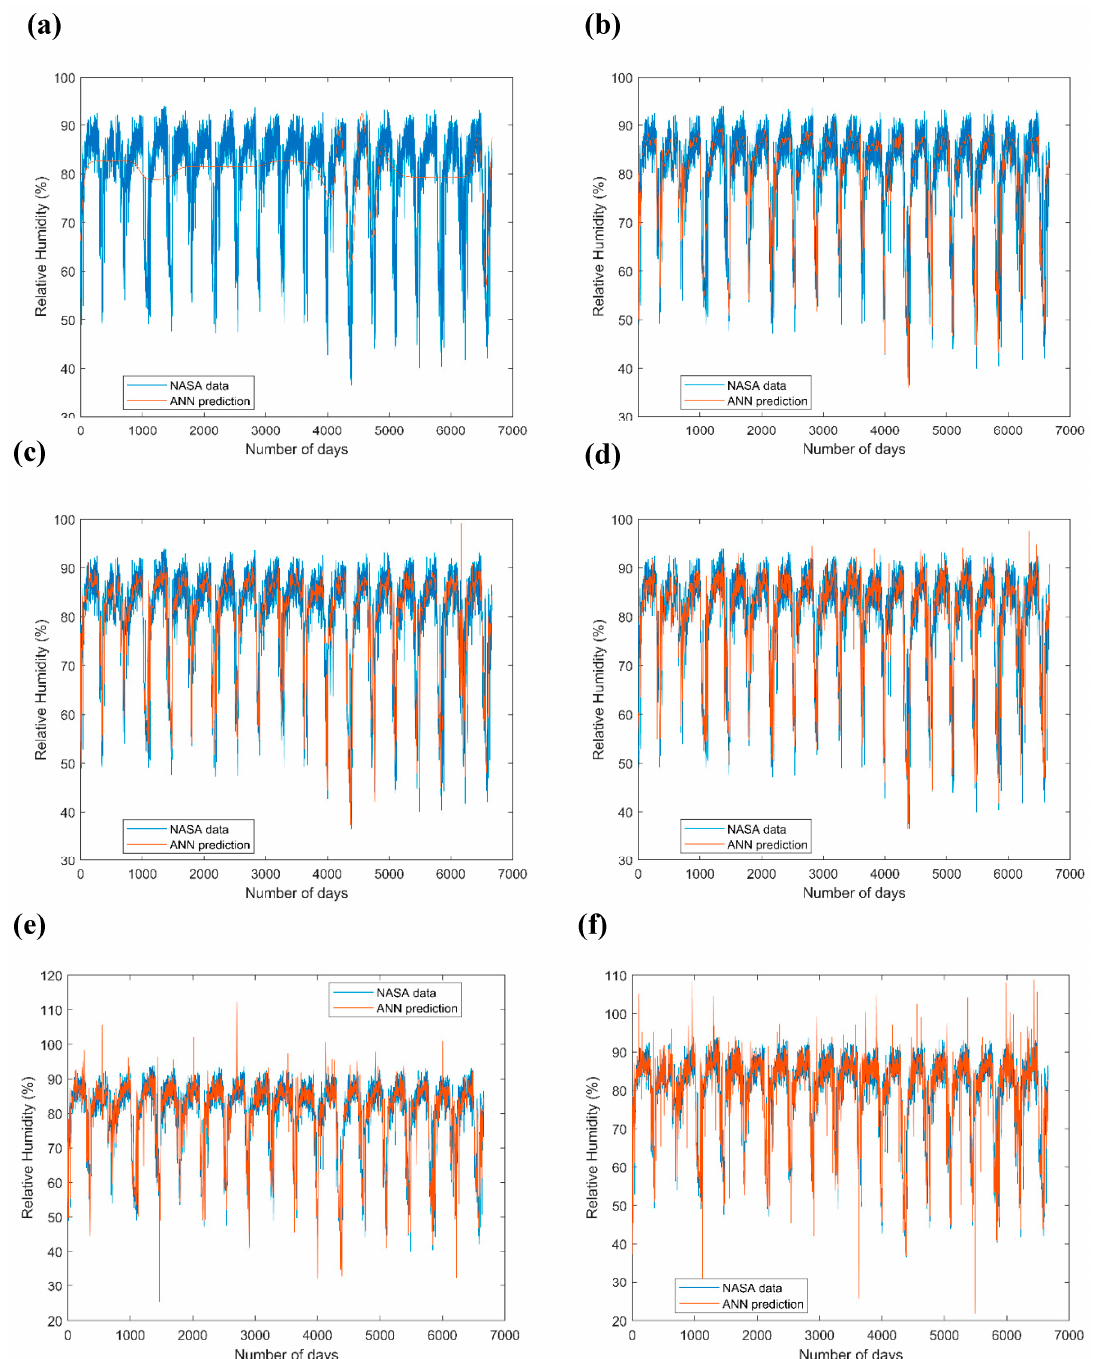
Figure 5. Relative humidity plot of the NASA data vs. the ANN model with ( a ) 10 hidden units, ( b ) 500 hidden units, ( c ) 1000 hidden units, ( d ) 1500 hidden units, ( e ) 2000 hidden units, and ( f ) 2500 hidden units.